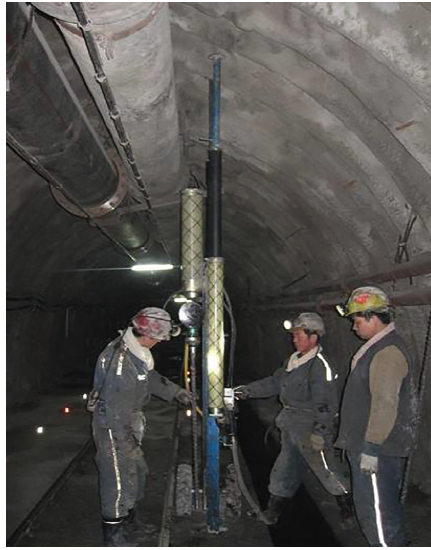
Figure 9: Anchor cable rig dedicated by the